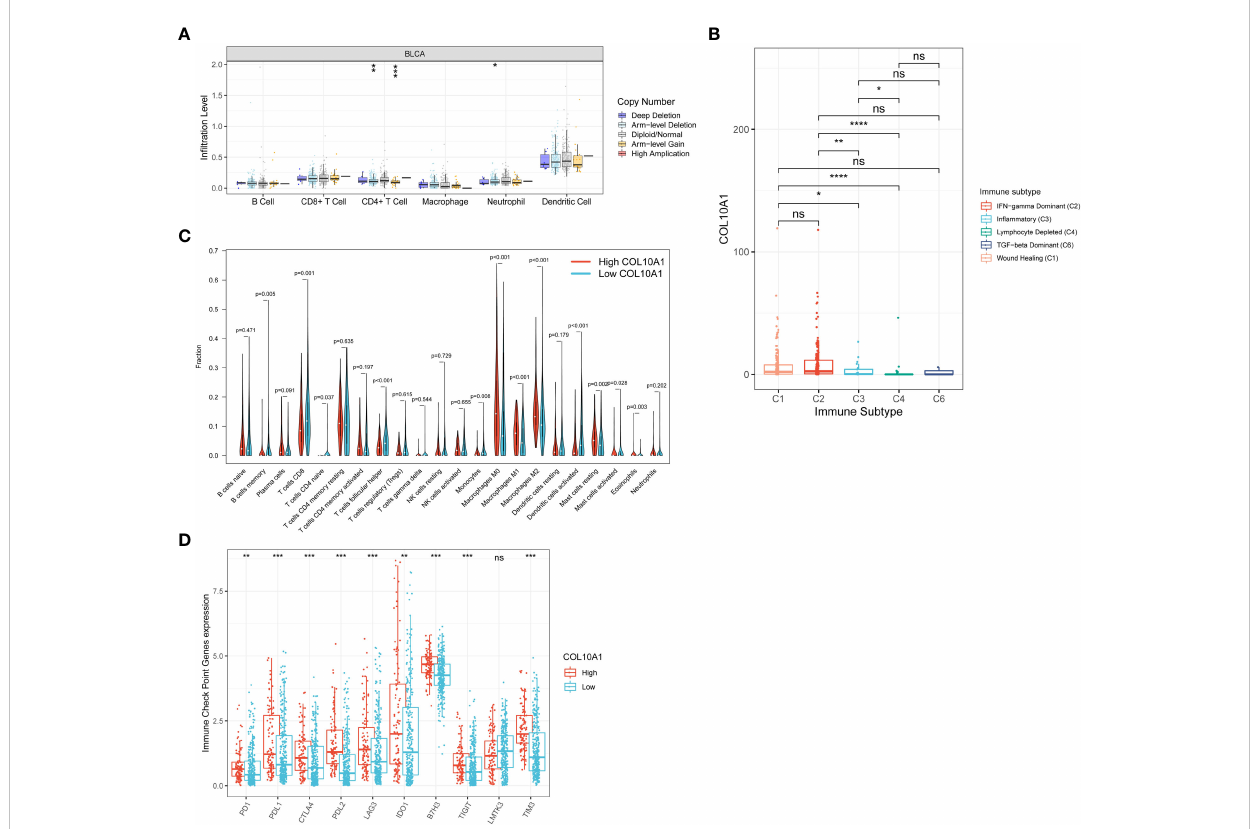
FIGURE 8 Correlation between COL10A1 and tumor immune in fi ltrating cells. COL10A1 CNV affects the in fi ltrating levels of CD4+ T cells in BLCA (A) . COL10A1 expression varied among different immune subtypes (B) . Changes of 22 immune cell subtypes between high and low COL10A1 expression groups in BLCA tumor samples (C) . Immune checkpoint genes expression between patients with high and low COL10A1 levels (D) . * P < 0.05; ** P < 0.01; *** P < 0.001; **** P < 0.0001. ns, not signi fi